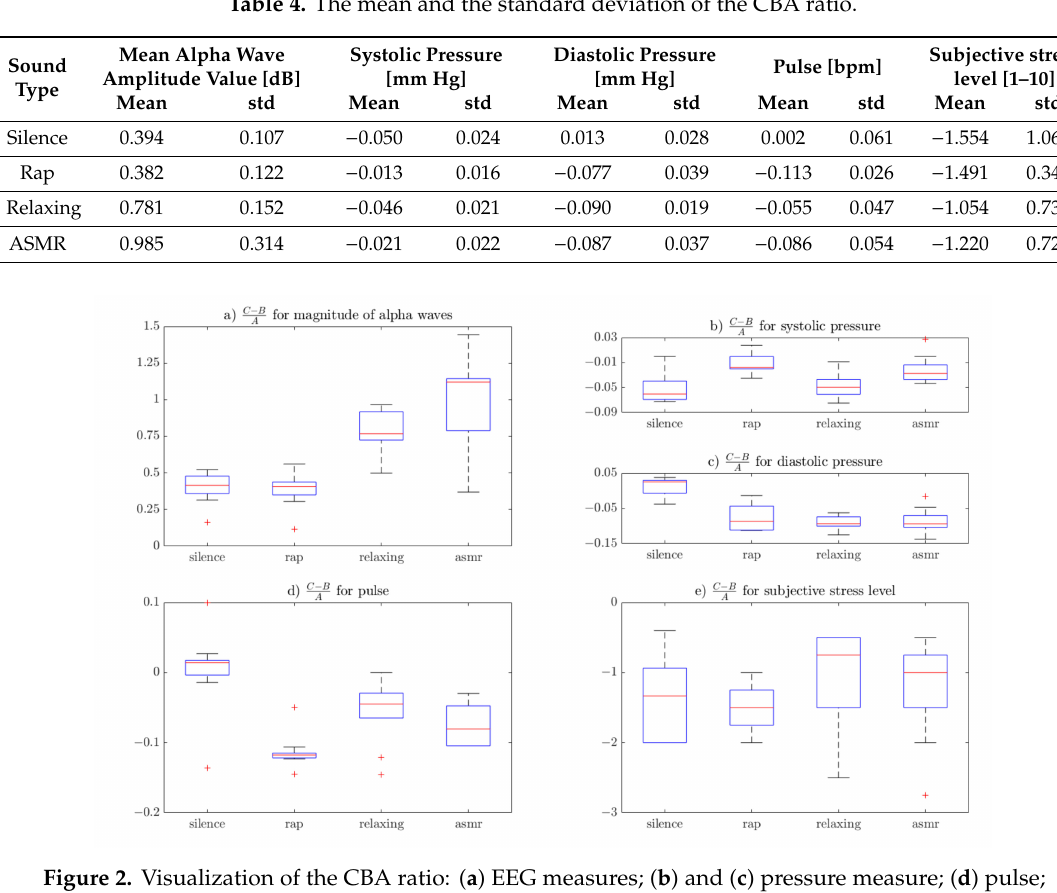
Figure 2. Visualization of the CBA ratio: ( a ) EEG measures; ( b ) and ( c ) pressure measure; ( d ) pulse; and ( e ) subjective stress